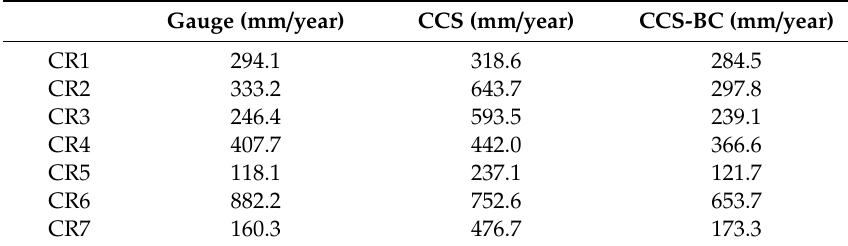
The areal averages of the mean annual precipitations for the seven climate regions (CRs) for the calibration period. CCS: Precipitation Estimation from Remotely Sensed Information using Artificial Neural Networks-Cloud Classification System (PERSIANN-CCS) and CCS-BC: PERSIANN-CCS-Bias-Corrected. Gauge (mm / year) CCS (mm /